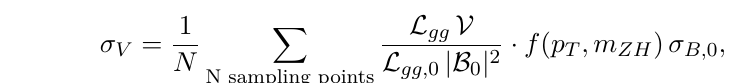
. The Padé-improved results are shown including up to T,Z ) , or quartic terms, ( m 4 ) , in m and m . For this comparison , m 2 , m 4 Z H Z H Z H